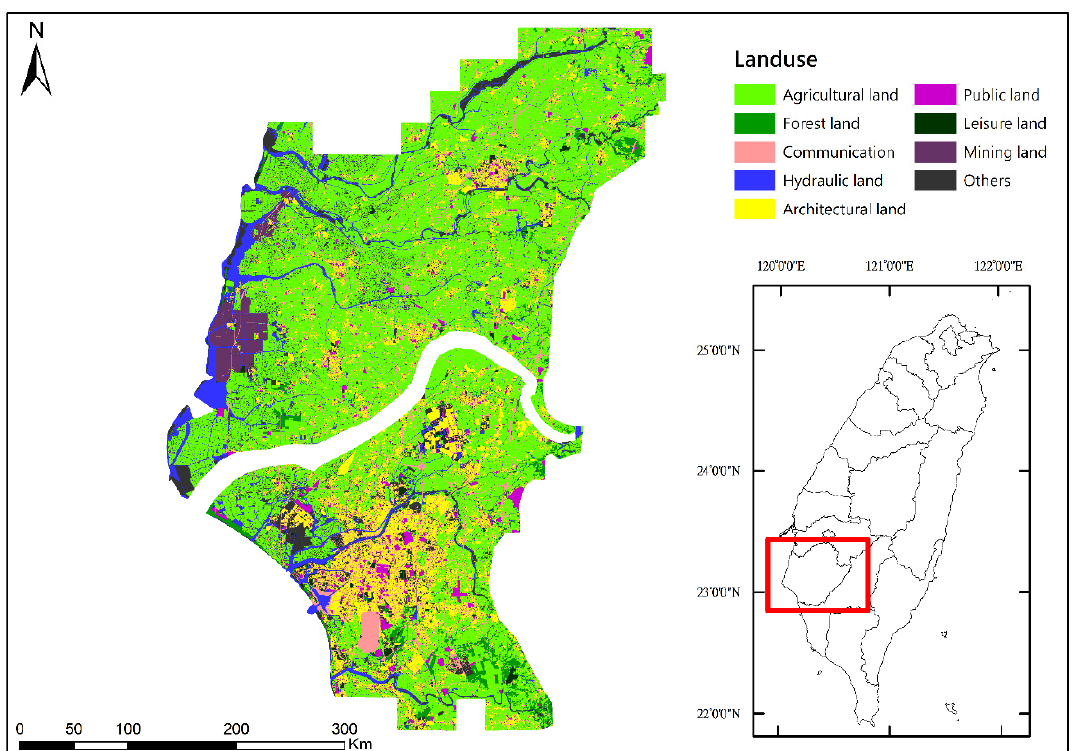
Figure 7. Spatial distribution of land use for the computational domain.